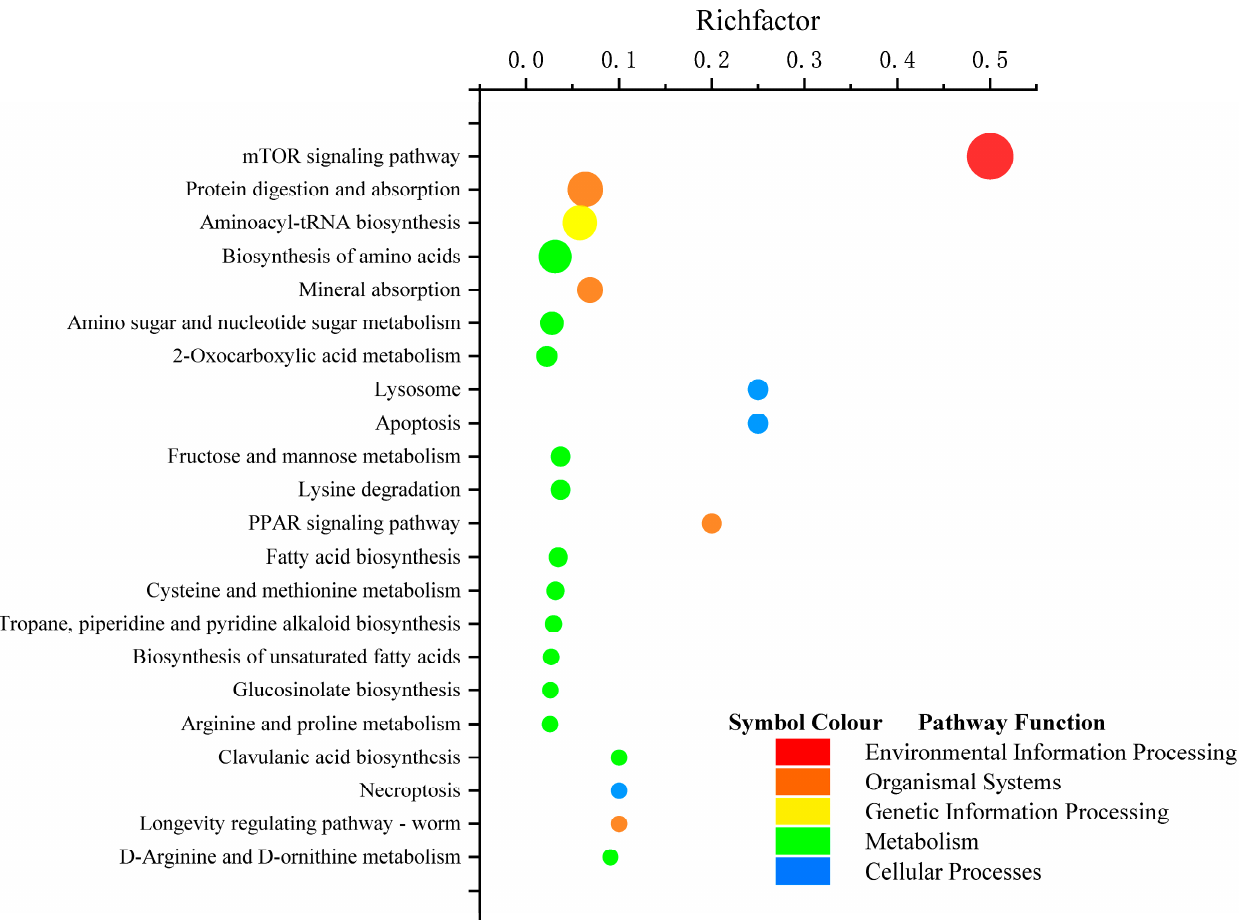
Figure 4. KEGG pathway enrichment analysis of the differentially accumulated metabolites in BR compared with BS.